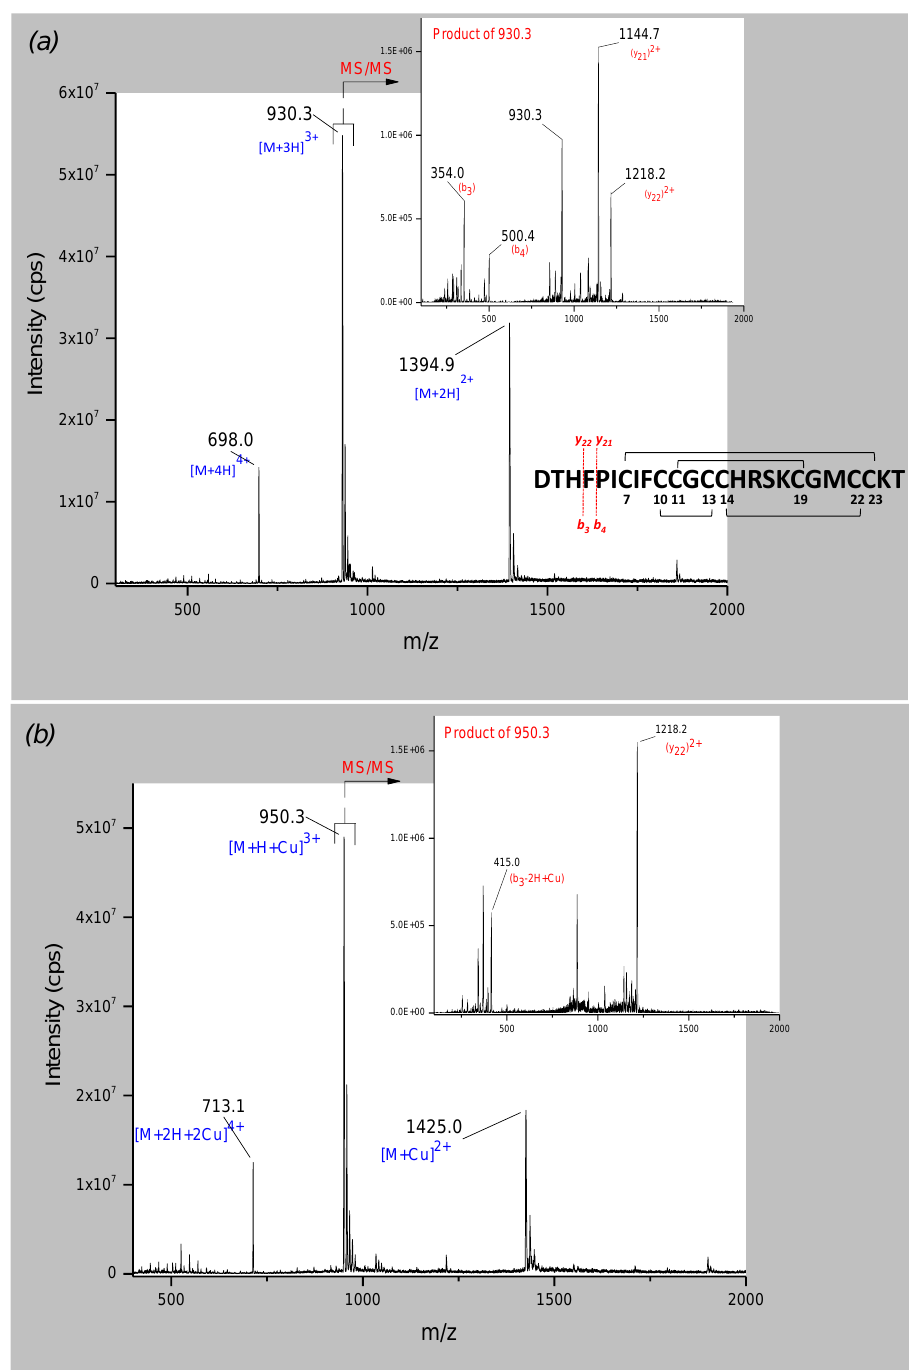
Figure 3. Full scan (mass spectrometry (MS)) and product ion spectra (tandem MS (MS/MS)) of ( a ) hepcidin-25 and ( b ) hepcidin-25-Cu 2+ . The fragmentation pattern presented in ( a ) is valid for both species. Analyzing the solution of hepcidin-Cu 2+ (molar ratio 1:10) revealed a hepcidin-25 species complexed with two Cu 2+ -ions. The double, triply and quadruply charged quasi-molecular ions were observed at m / z 1456.1, 971.0, and 728.5, respectively, but the signal intensity was lower compared to the other two species (see Supplementary Material Figure S5). The product ion spectra of the triply